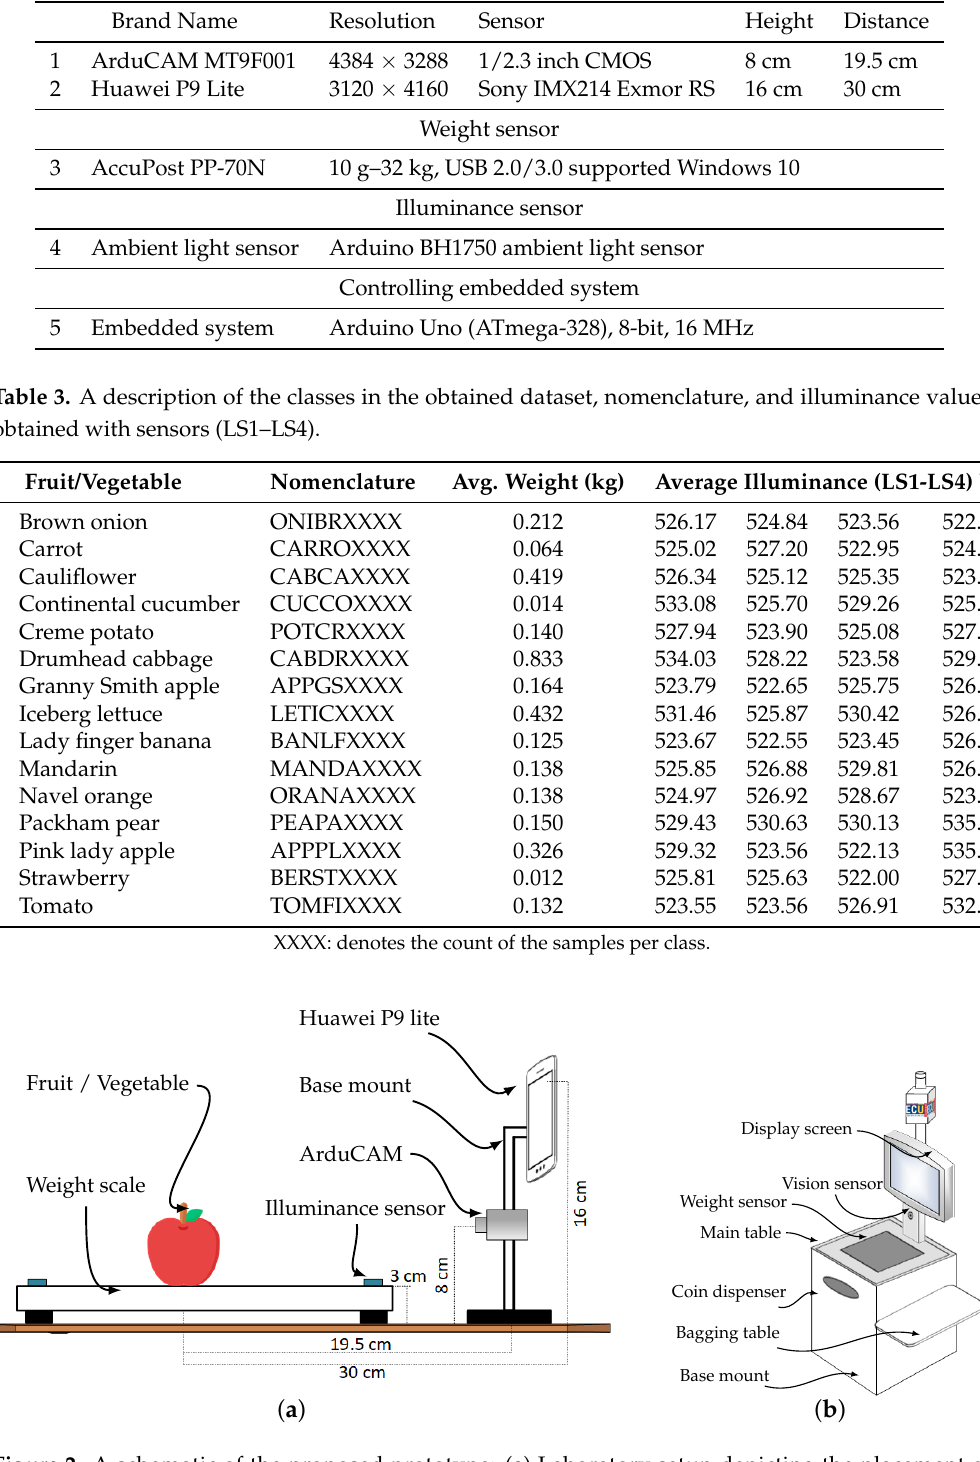
Figure 2. A schematic of the proposed prototype: ( a ) Laboratory setup depicting the placement of vision sensor, illuminance sensors, weight sensor, and fruit or vegetable sample, and ( b ) A proposed placement of sensors on a typical supermarket self-checkout